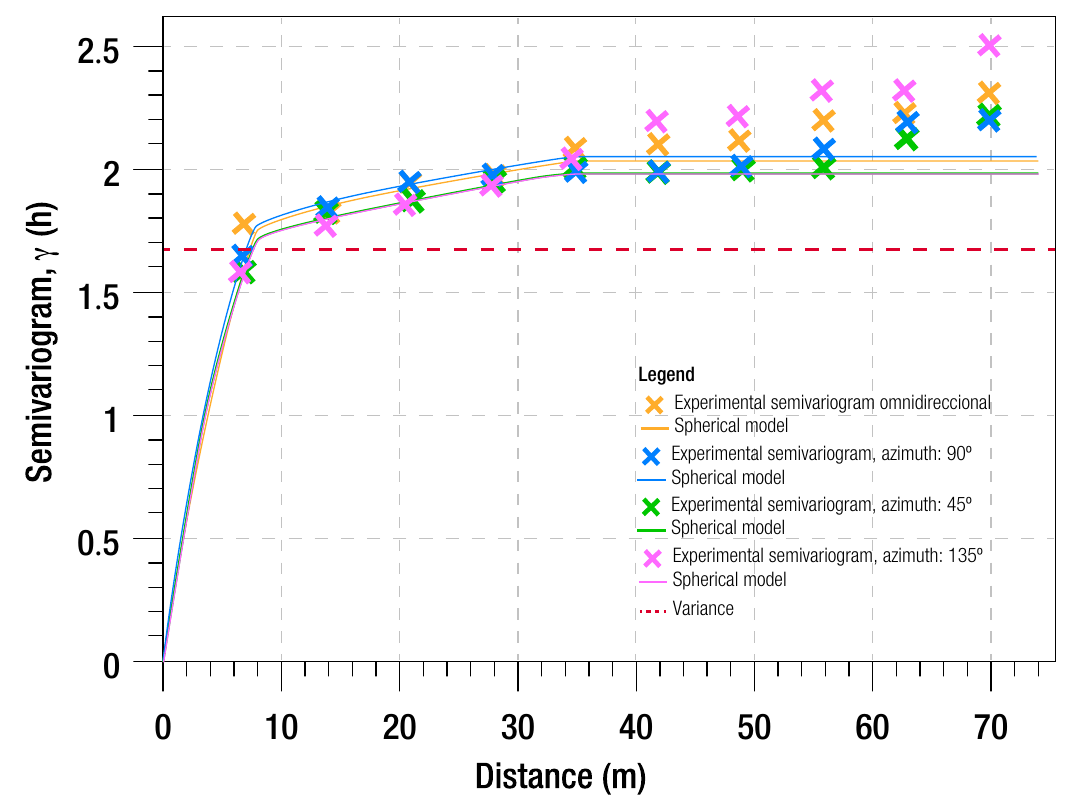
Figure 8. Experimental semivariograms and theoretical models for q d . Horizontal analysis